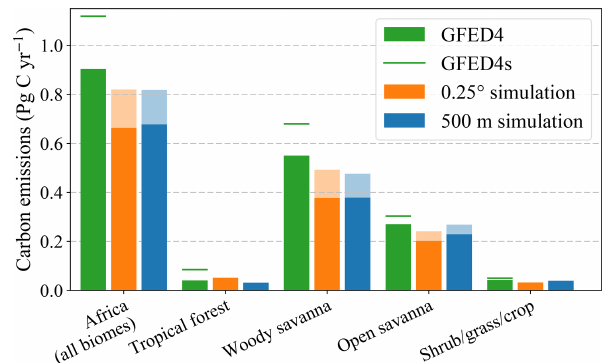
Figure 3. Total fire emissions for sub-Saharan Africa and individual biomes, as compared to GFED4 (without small fires) and GFED4s (with small fires). Solid orange and blue bars show the estimates based on the 500m resolution model calibration. Transparent bars show the estimates based on the 0.25 ◦ resolution model calibration, highlighting that the calibration difference is larger than the simu- lation